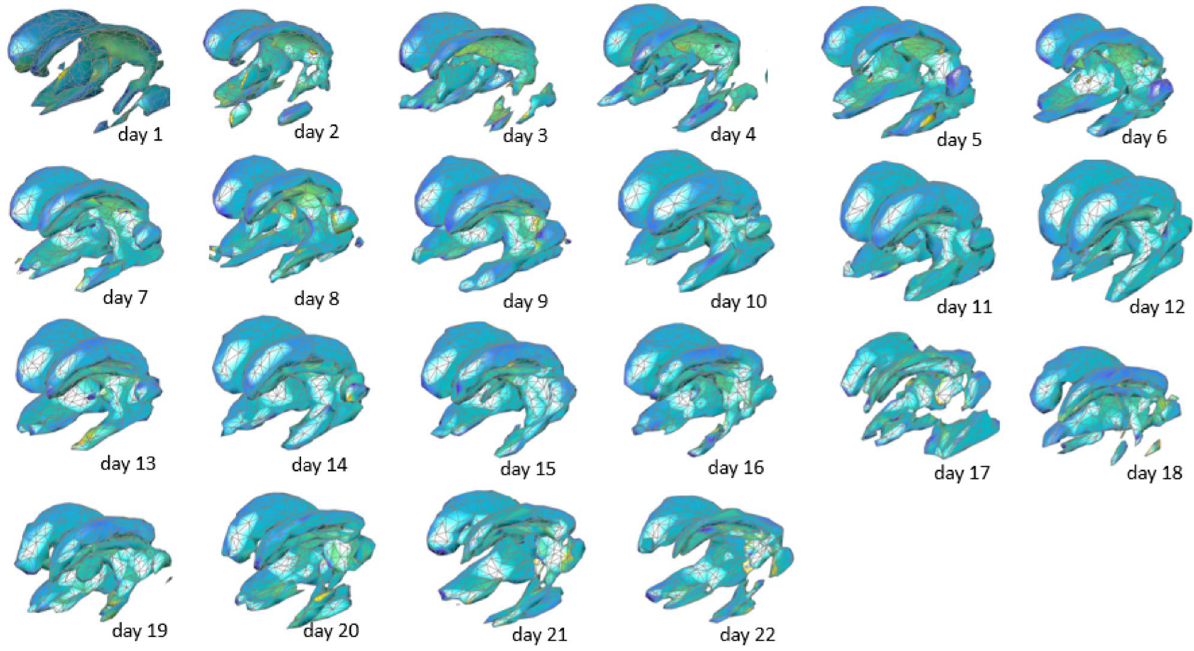
Figure 6. Temporal evolution of ventricular of the ventricular system of one patient (id1) over a period of 22 days measured automatically using deep learning-based segmentation.